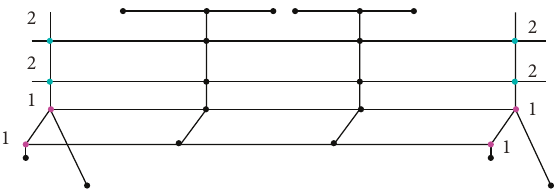
Figure 23: Local analysis model of the circular catwalk.